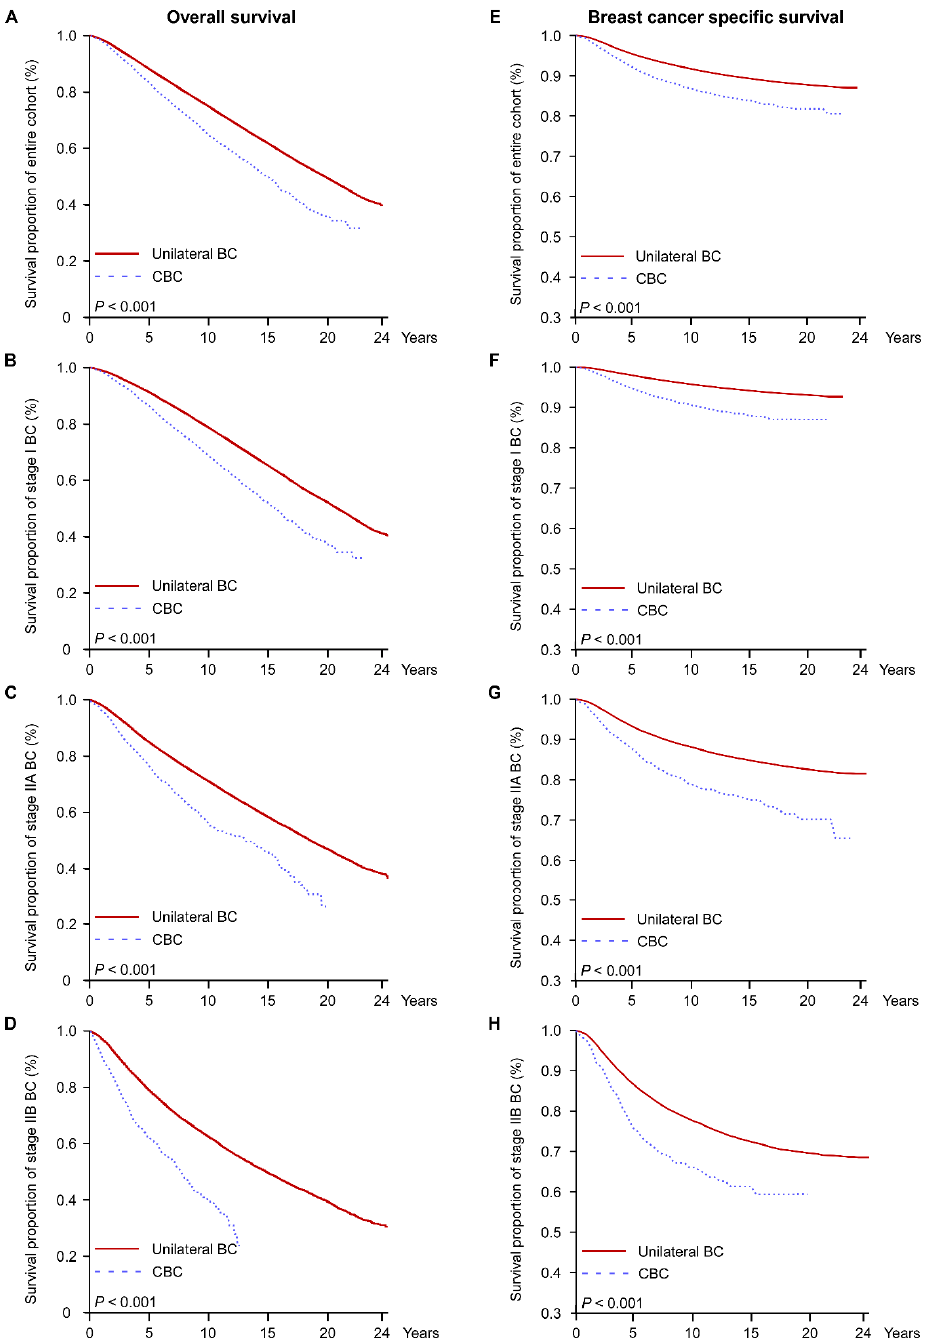
Figure 2. Overall and BC-specific survival analyses adjusted using the propensity scoring (PS) model between patients with early-stage unilateral BC and patients with early-stage CBC. All values are based on the PS model. Left - overall survival (OS): ( A ) entire cohort, ( B ) stage I, ( C ) stage IIA, and ( D ) stage IIB. Right—BC-specific survival: ( E ) entire cohort, ( F ) stage I, ( G ) stage IIA, and ( H ) stage IIB. BC = breast cancer; CBC = contralateral breast cancer.